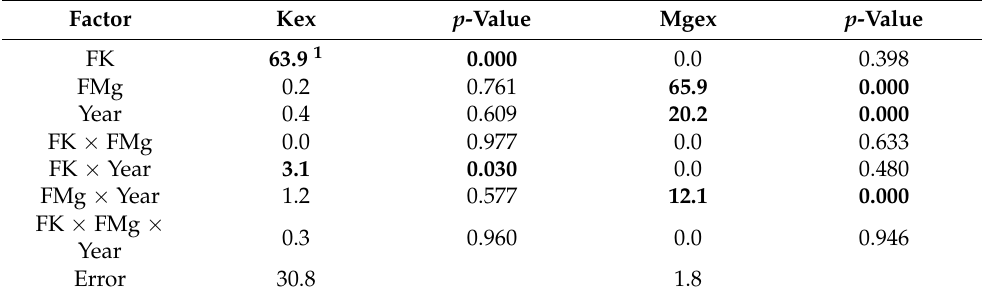
Table 8. ANOVA results: factor contribution (%) to the total variance of soil exchangeable K and Mg content in the microplot field experiment with potassium (FK) and magnesium fertilization (FMg).